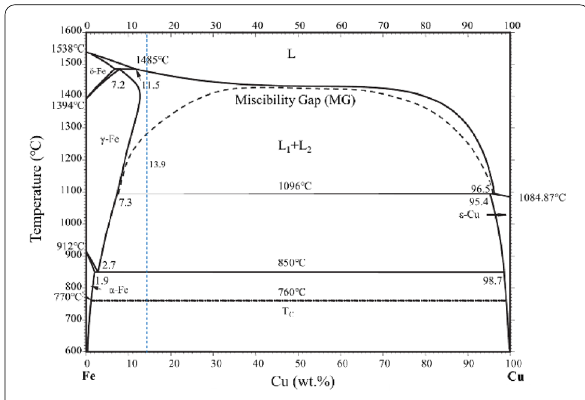
Figure 14 Cu-Fe binary phase diagram with metastable miscibility